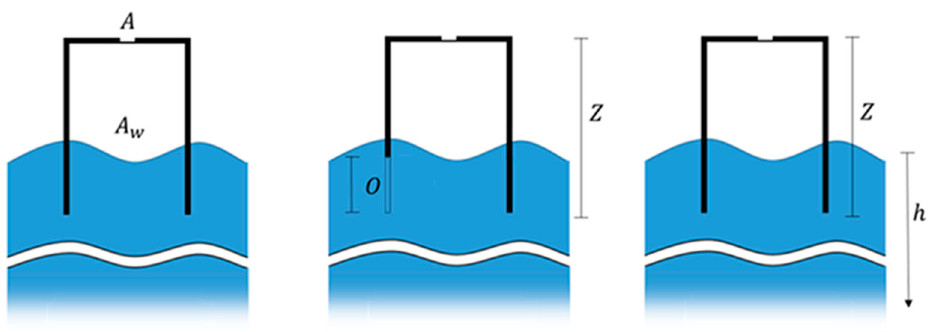
Figure 4. Consideration for various shapes of air-chamber of the OWC wave energy converter installed in an offshore template structure.